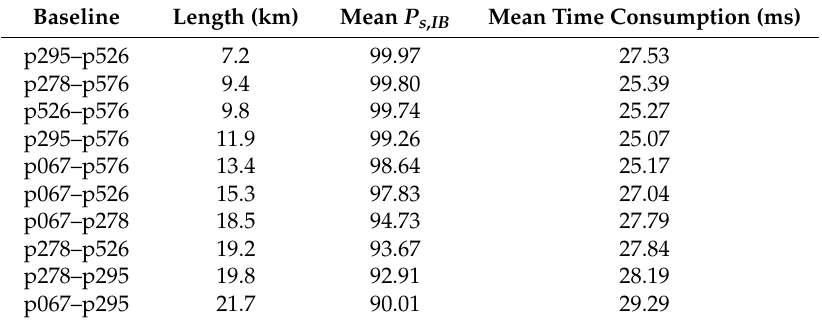
Table 2. The mean time consumption of the real-time kinematic (RTK) processing with the Table 1. The mean time consumption of the real-time k inematic (RTK) processing with the FL- approach.